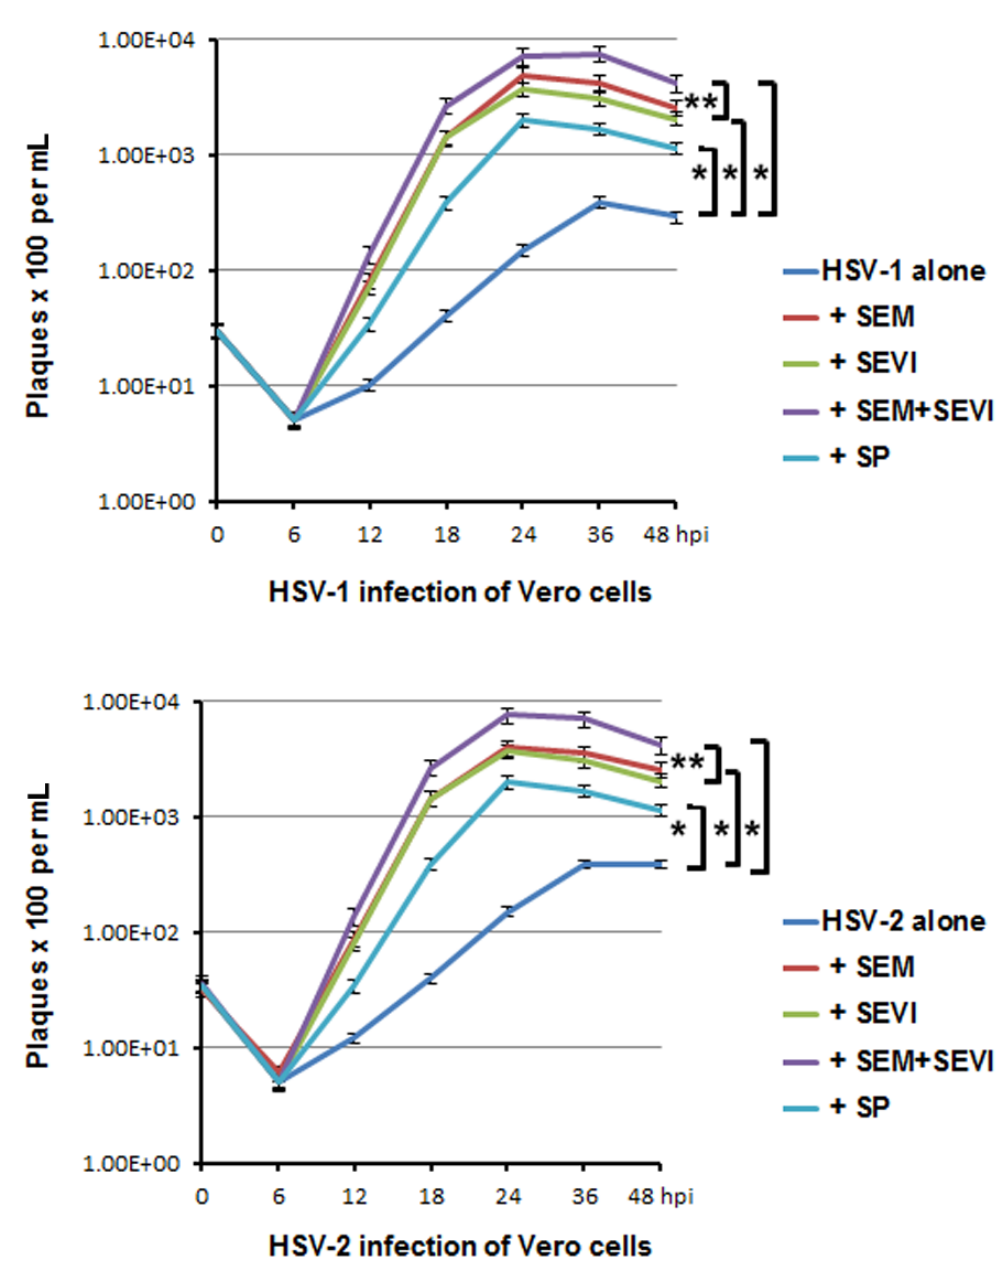
Figure 5. Viral growth curve assay. ( Upper ) HSV-1 infection of Vero cells . Vero cells were infected with virus alone or with virus treated with SP (1:1000 dilution), SEM amyloids (5 μg/mL), SEVI (5 μg/mL), or SEM amyloids (5 μg/mL) plus SEVI (5 μg/mL) at an MOI of 0.1 for a differing number of hours (as indicated). One well of each culture was collected (along with medium) at the indicated hpi and stored at −80 °C. The collected cells (with medium) were frozen/thawed for three cycles and then centrifuged at 8000 g for 20 min to remove the cellular debris. To perform a pfu assay, 25 μL of supernatant of each sample was used to infect Vero cells in triplicate; ( Lower ) the same as described in the above, except that the Vero cells were infected with HSV-2. Student’s t -test was used to statistically analyze the differences between the groups versus virus alone ( * p < 0.001) and those between the group of SEM + SEVI versus SEM or SEVI ( ** p <